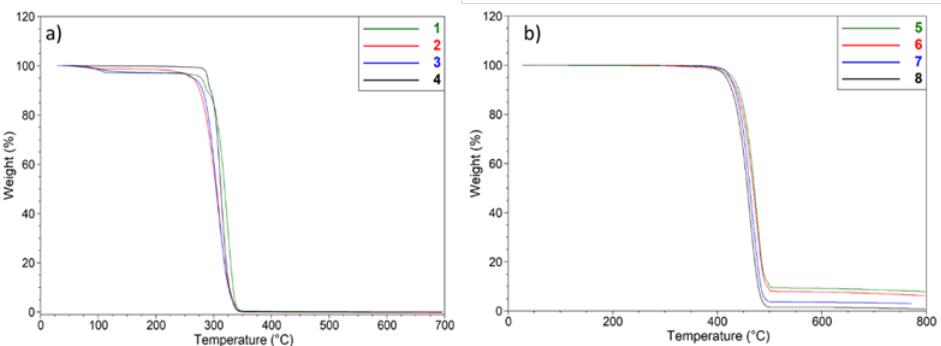
Figure 2. Thermal gravimetric analysis of bromide ( a ) and Tf 2 N BDILs ( b ).